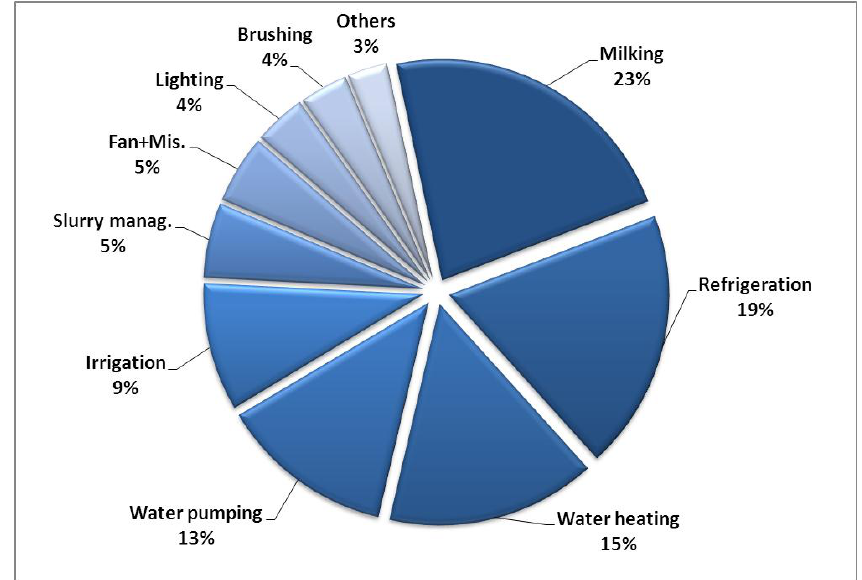
Energies 2018 , 10 , x